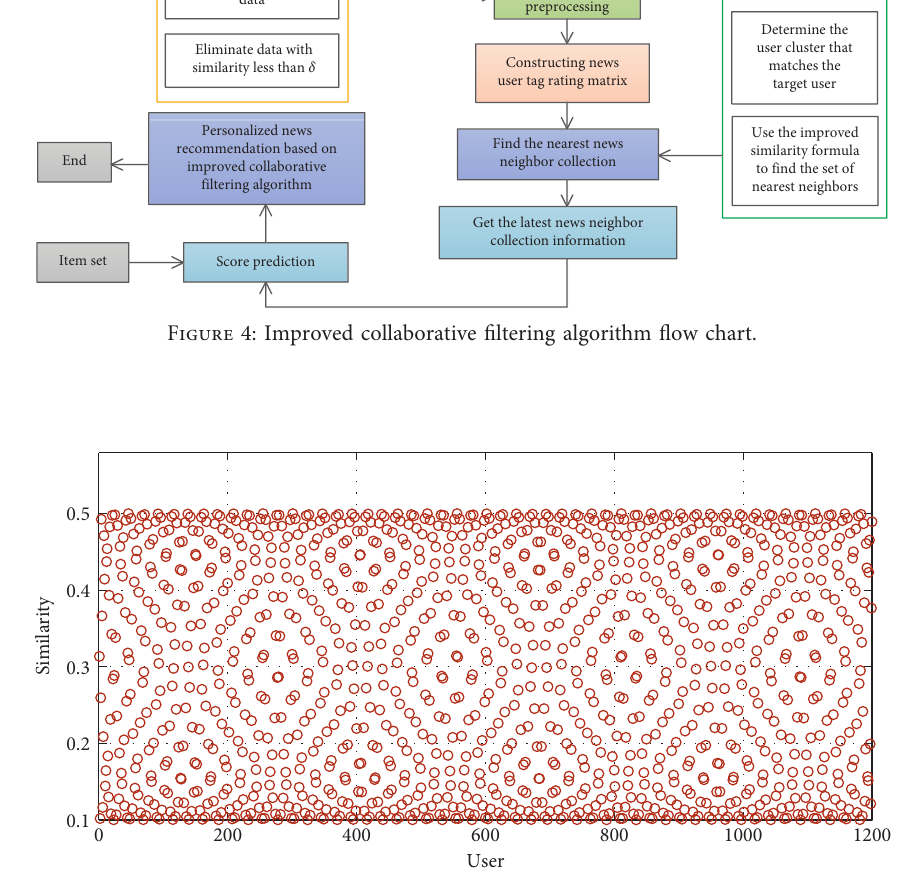
Figure 5: The distribution of similarity between users under the cosine similarity index.